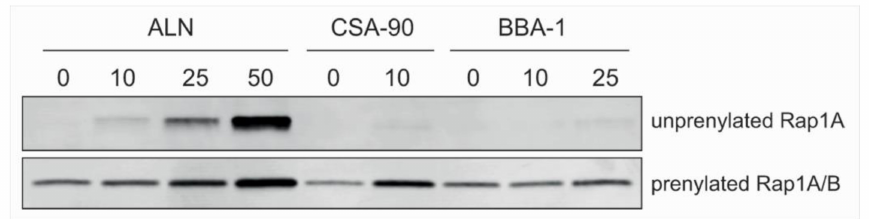
Figure 9. Effect of BBA-1 on protein prenylation in J774.2 macrophage cells. ALN treatment inhibited Rap1A prenylation in J774.2 cells at 10 µ M or above but CSA-90 and BBA-1 had negligible effects. Prenylated Rap1A/B was used as a loading